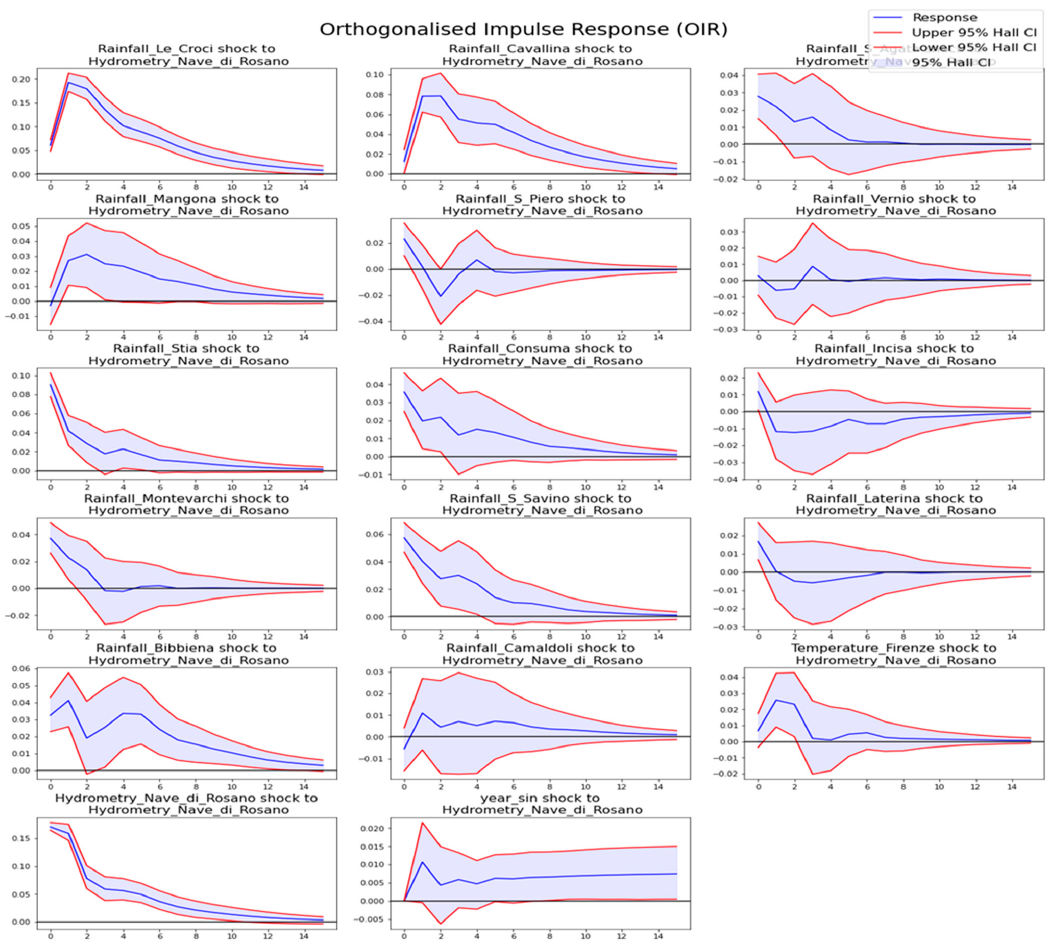
Figure 9. OIR plot of Hydrometry_Nave_di_Rosano(Flow_rate)-RIVER-ARNO.